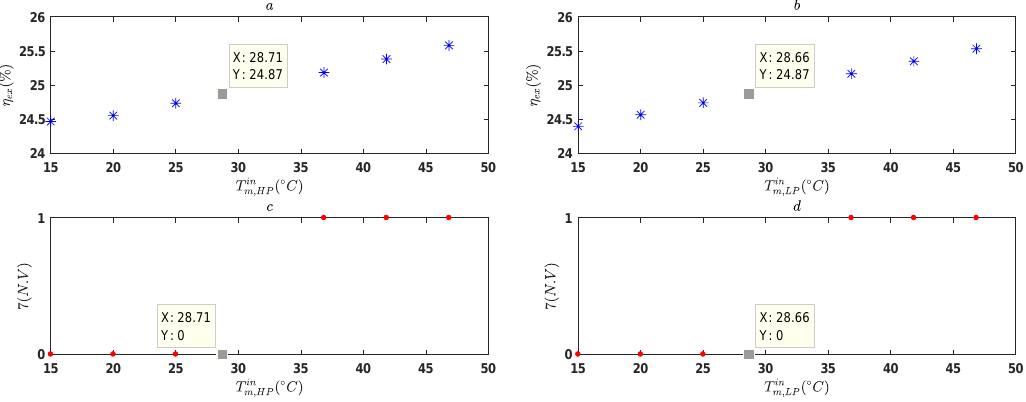
Figure 12. Variation of global exergy efficiency and number of violated constraints with inlet temperature of high-pressure ( a , c ) and low-pressure ( b , d ) expansion stages of pneumatic motor at optimal